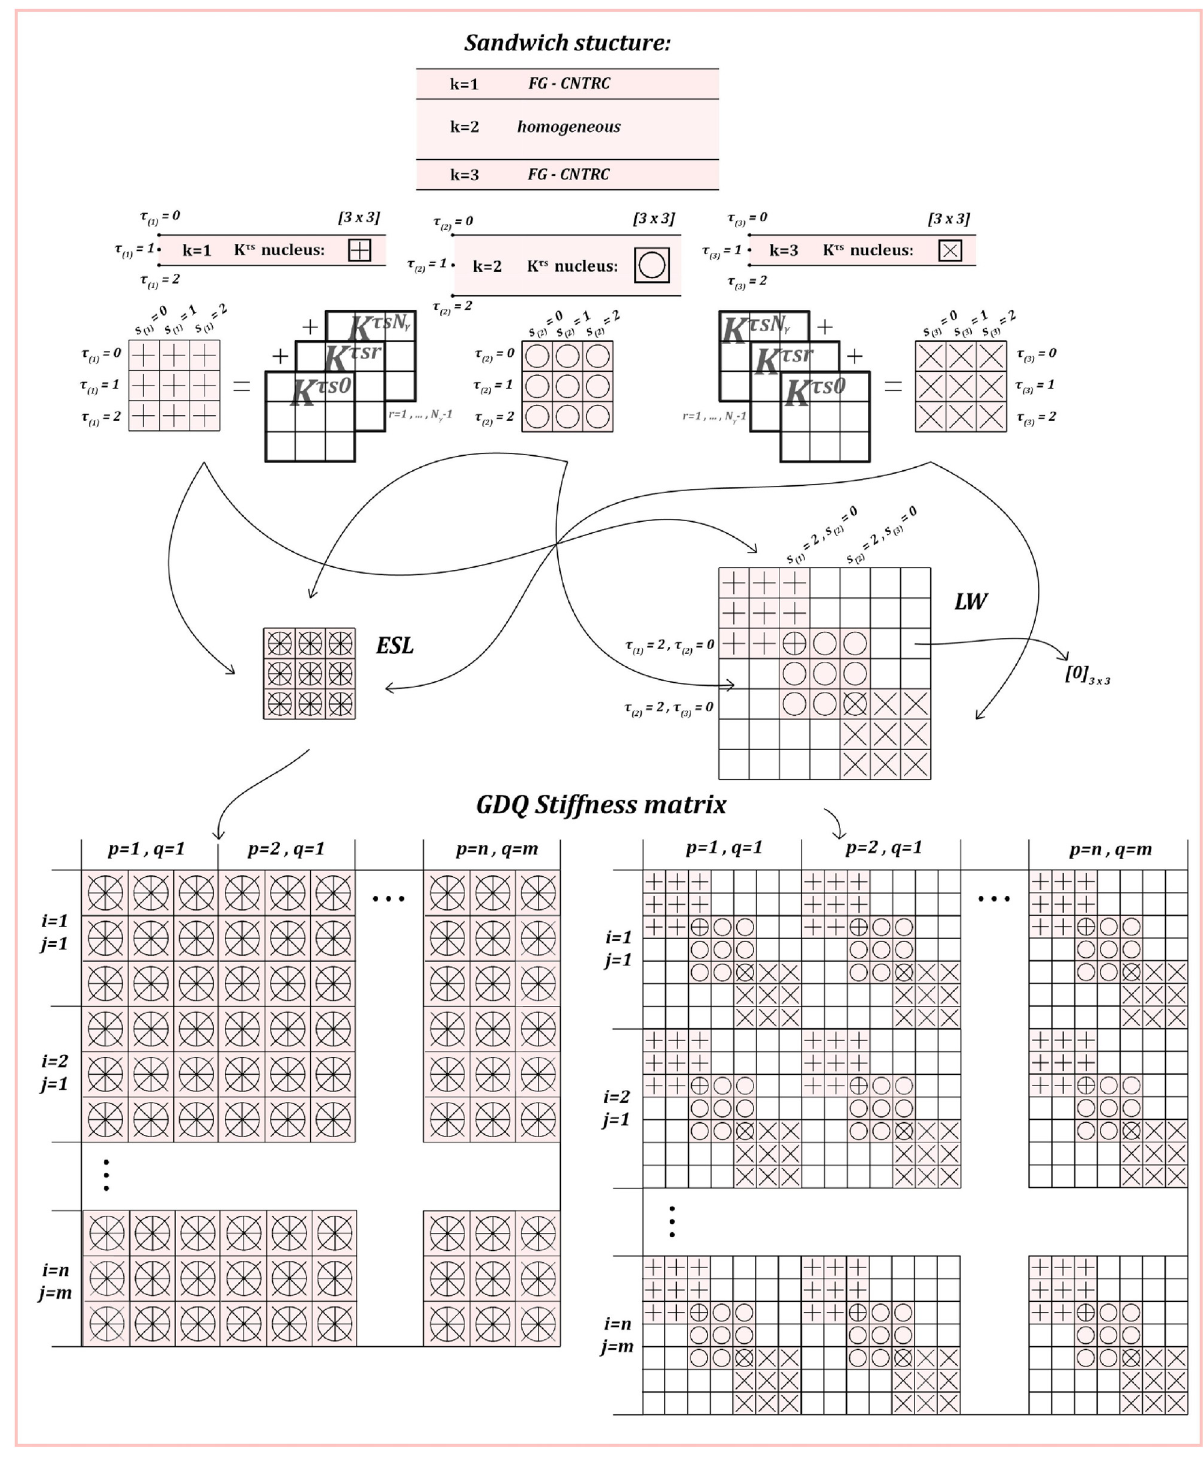
Figure 7: Fundamental nucleus assembly procedure for a sandwich structure with FG - CNTRC face sheets via GDQ grid points [ 122 ] ( the order of expansion through the thickness N = 2 and n × m GDQ grid points )